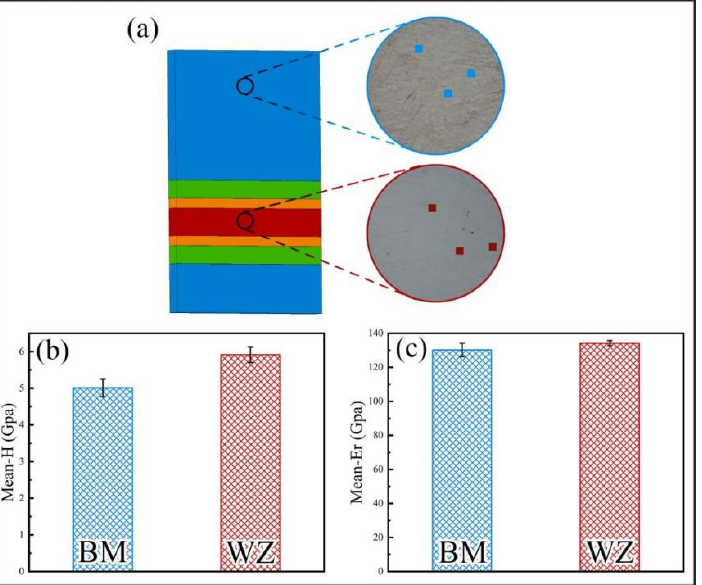
Figure 3. (a) Schematic diagram of nanoindentation test; ( b ) Nanohardness of BM and WZ; ( c ) equivalent Young’s modulus of BM and